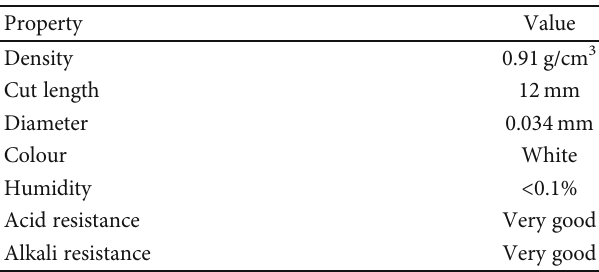
Figure 1: Particle size distribution of the natural soil. Table 2: Properties of polypropylene fi